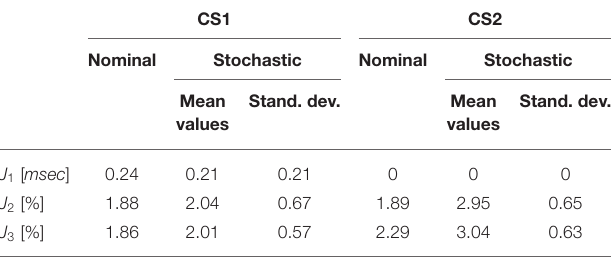
TABLE 2 | Tracking controller performance and robustness results for CS1 and CS2. CS1 CS2 Nominal Stochastic Nominal Stochastic Mean Stand. dev. Mean Stand. values values